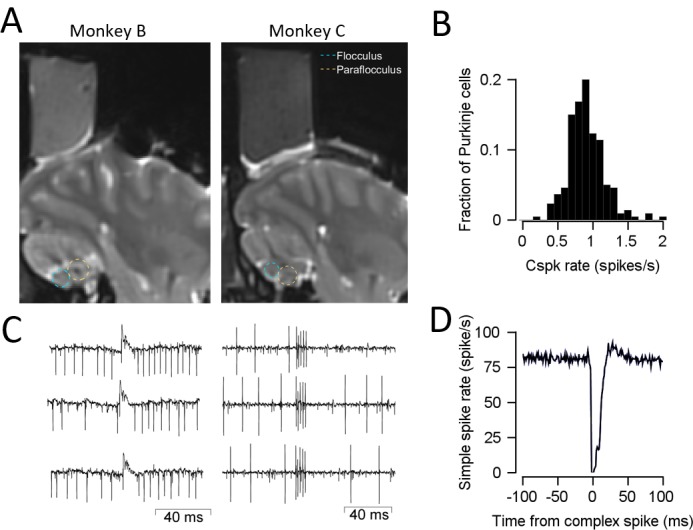
MRI and examples of extracellular recordings of Cspks.(A) MRI of the sagittal section 11 mm lateral to the midline. Chambers were placed above the floccular complex and neighboring areas. The cyan ellipses represent the approximate location of the Flocculus and the yellow ellipses the approximate location of the Paraflocculus. (B) Histogram of the average firing rate of cells. The histogram is centered around 1 Hz with is typical for Cspks. (C) Example of extracellular recordings of Cspks from two neurons. Each column shows Cspks from the same neuron. (D) The cross-correlation of simple spikes to complex spikes, which is essentially a PSTH of Sspks aligned to the event of a Cspk occurrence. The prolonged decrease in Sspk rate following a Cspk is consistent with the literature (Schonewille et al., 2006; Yang and Lisberger, 2014).